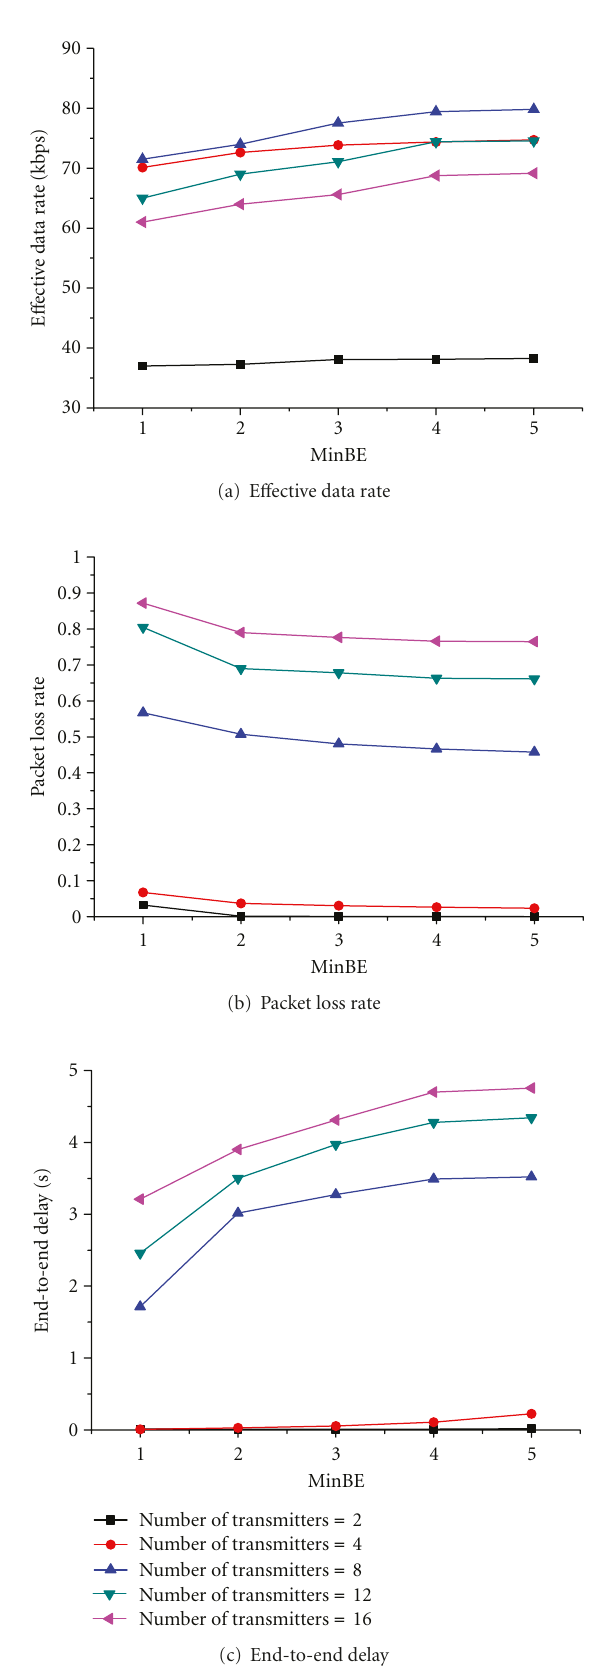
Figure 6: QoS with di ff erent MinBE